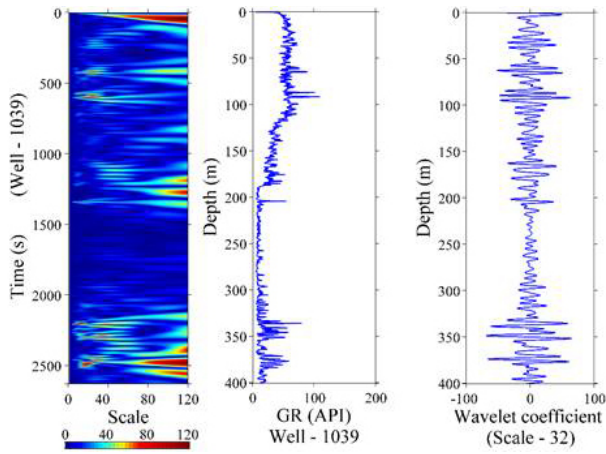
Figure 6. Continuous wavelet transform (CWT) using gamma ray signal and the wavelet coefficient at scale 32 of the gamma ray log of well site 1039.